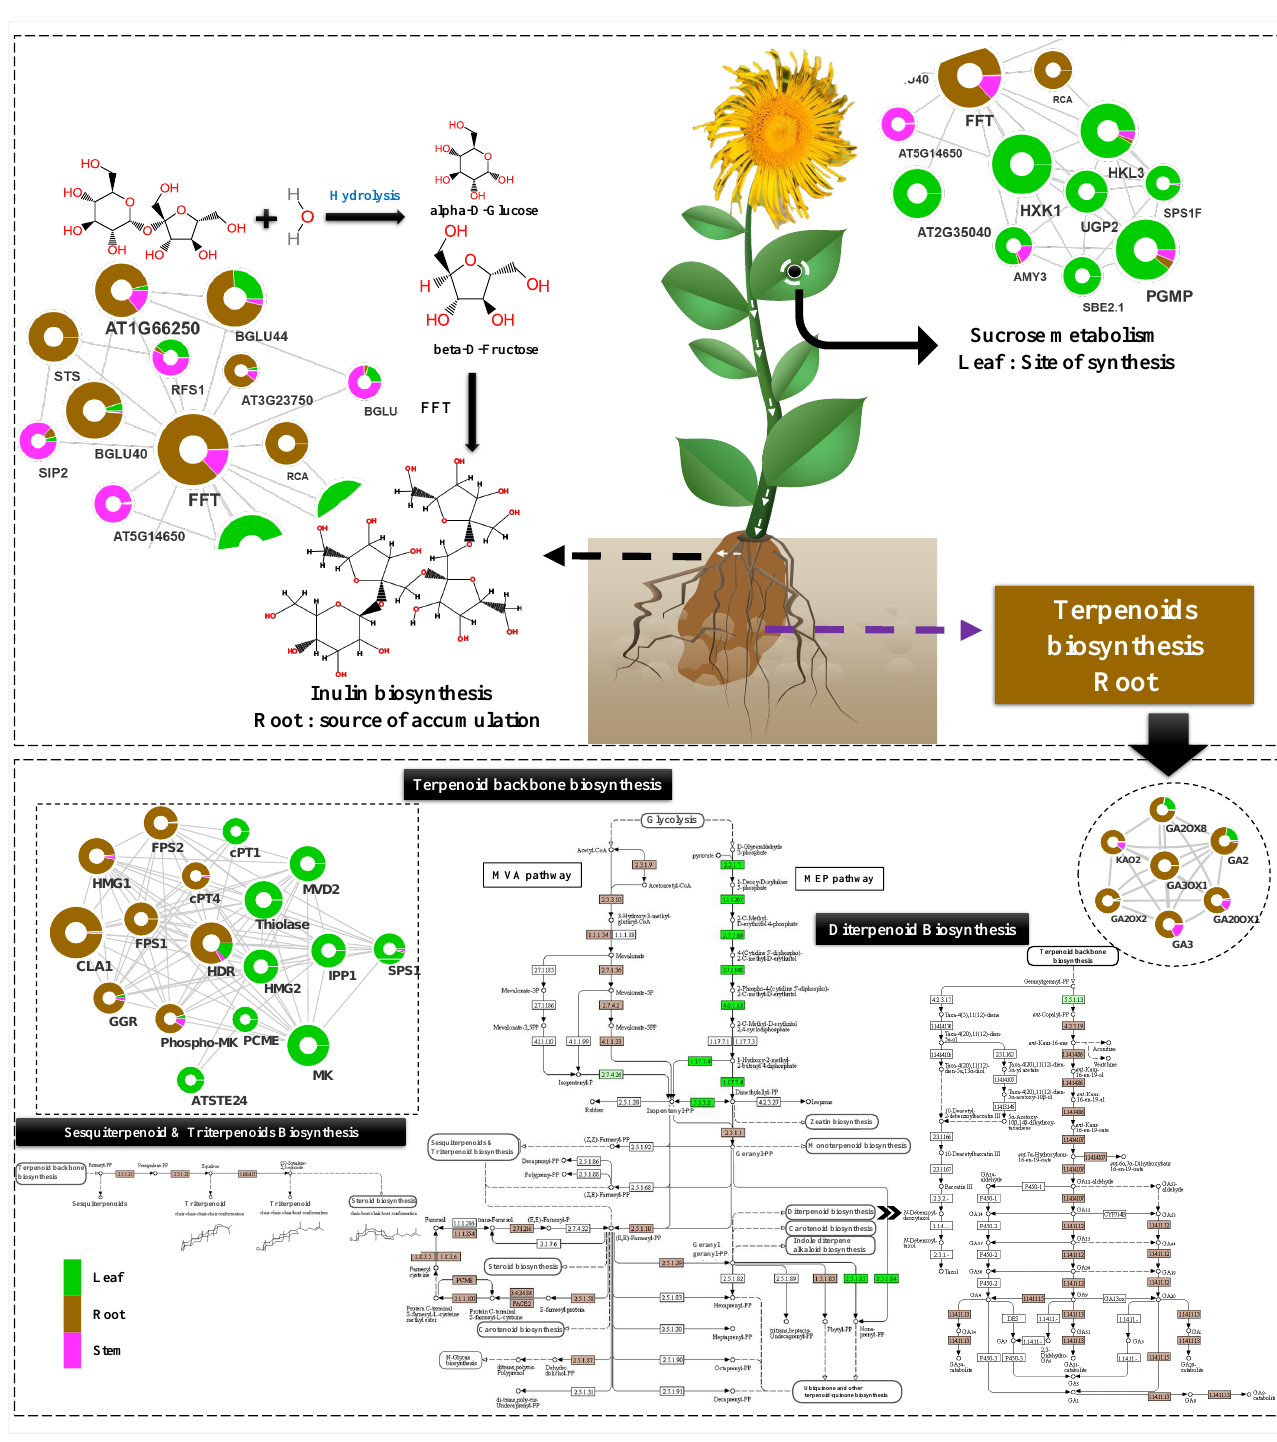
Figure 10. Illustration representing spatial expression of terpenoid and inulin biosynthesis in I. racemosa